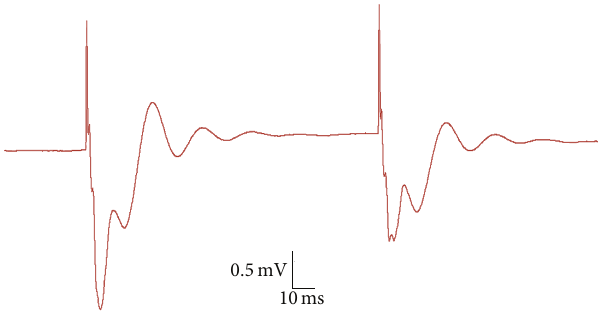
Figure 3: Typical fPSPs recorded in A1 following paired-pulse MGN stimulation. The trace depicted was elicited with an ISI of 100ms and illustrates an example of PPD, with the amplitude of the second fPSP (first peak) suppressed relative to the first